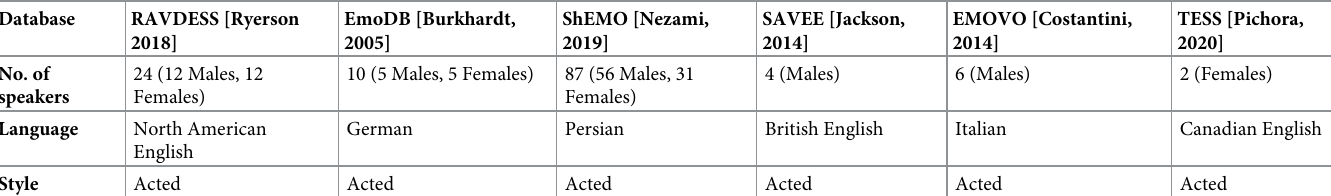
Table 1. Detail of datasets used for speech emotion